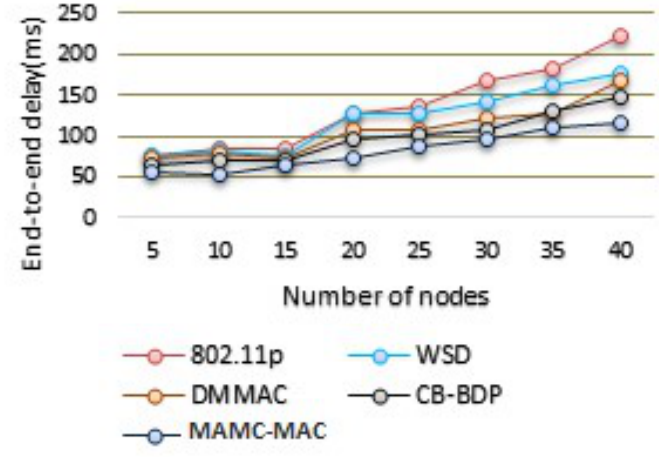
Figure 9. Average end-to-end delay comparison.